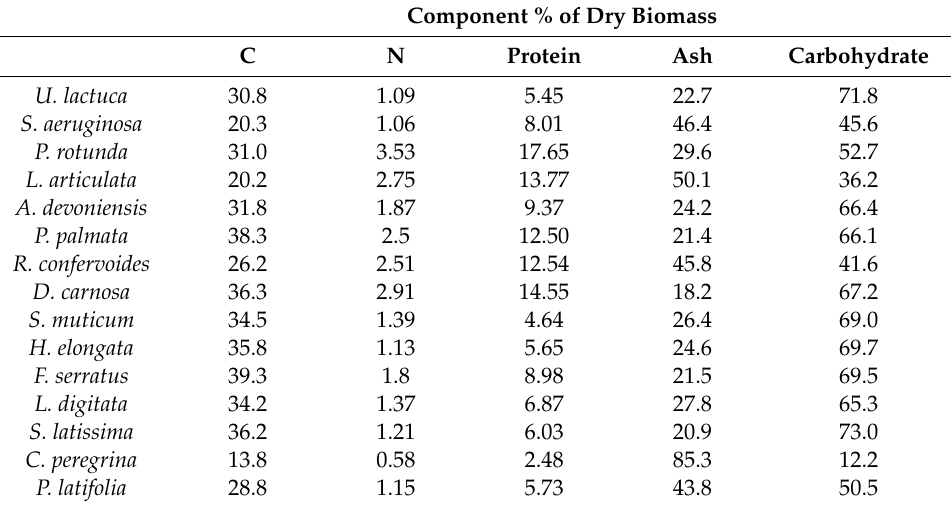
Table 4. Carbon (C), nitrogen (N), protein, carbohydrate and ash content of seaweeds from South West